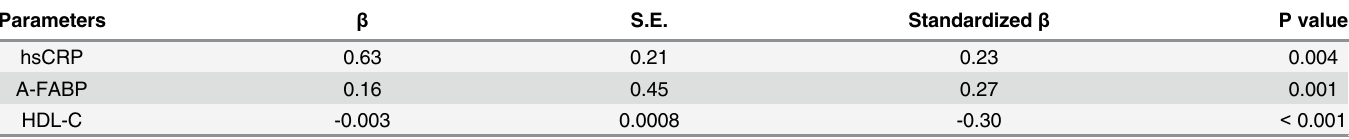
Table 3. Multiple stepwise regression analysis showing the variables independently associated with the serum level of ANGPTL2.